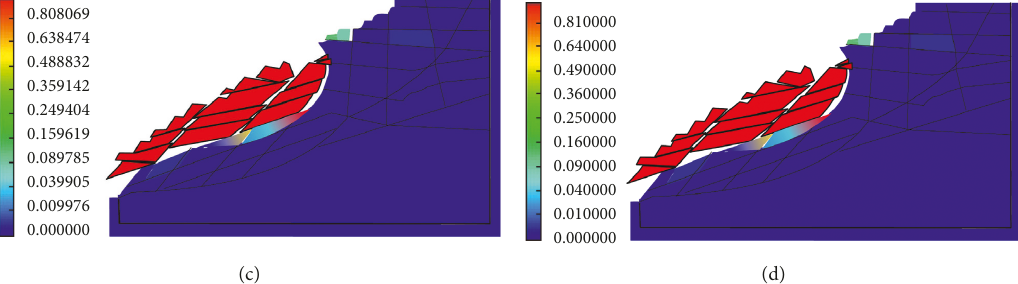
Figure 9: First failure process of the northern slope in the Fushun West Open-Pit Mine: (a) step 1.361 × 10 6 ; (b) step 1.363 × 10 6 ; (c) step 1.365 × 10 6 ; (d) step 1.367 × 10 6 .